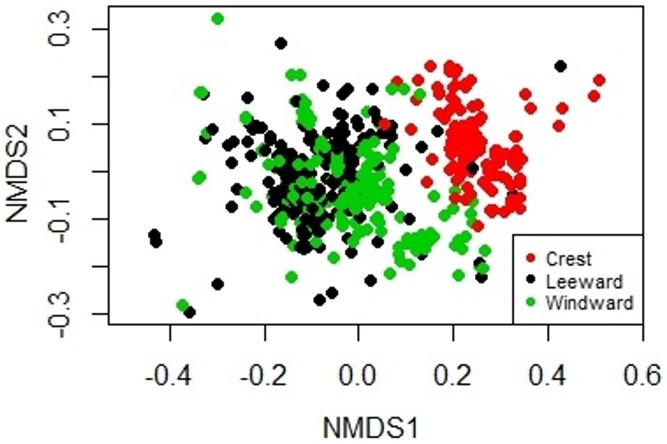
Non-metric Multidimensional Scaling biplot showing the similarity on the biological composition between sampling units taken at the windward, reef crest and leeward zones of Madagascar reef, Gulf of Mexico.